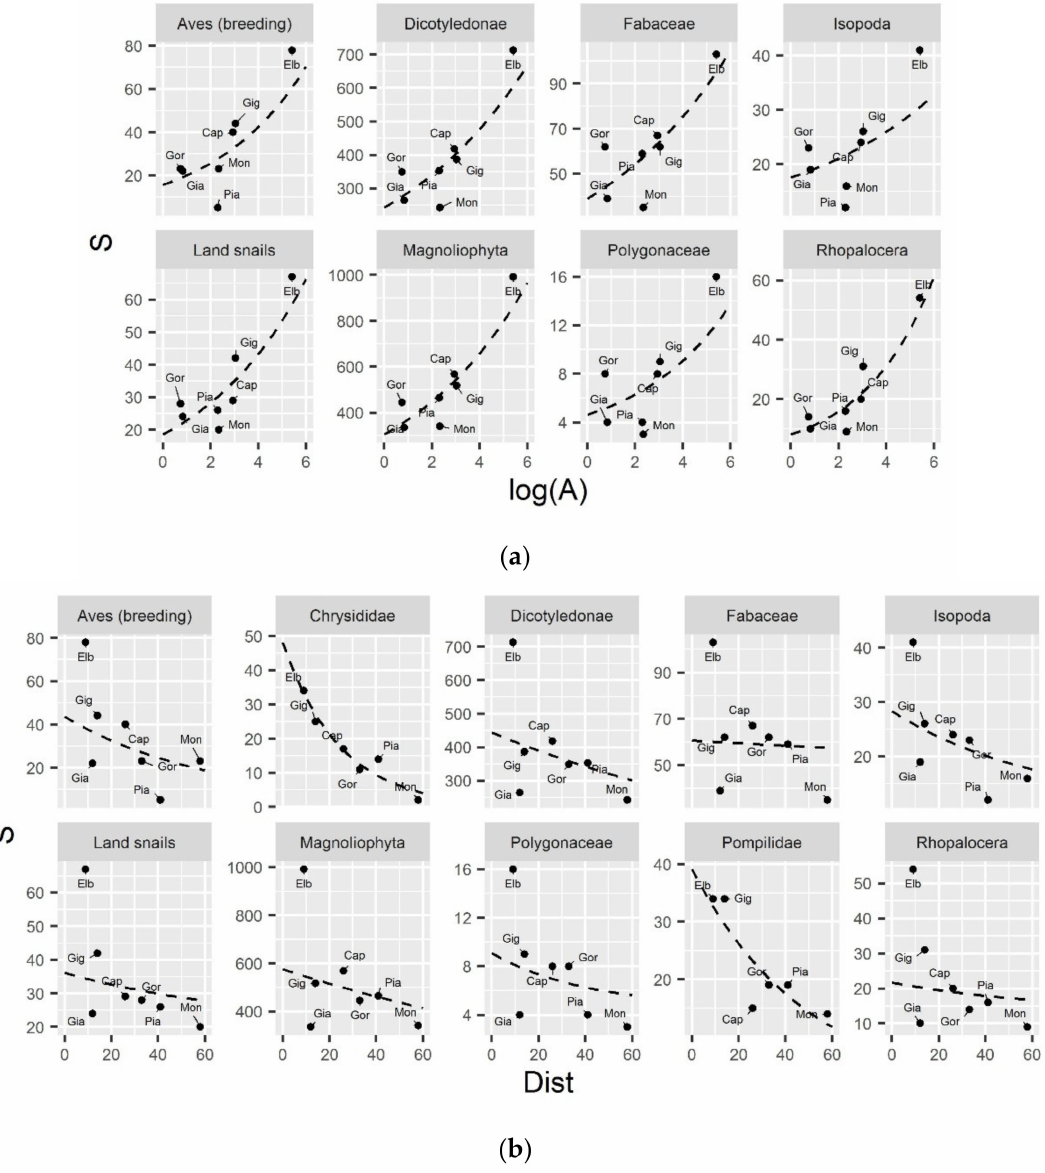
Figure 3. Equilibrium Hypothesis (EQH) according to the Logarithmic function: joined effect of logarithm of island area (log(A)) ( a ) and distance (D) ( b ) on species richness (S) of animal and plant taxa in the Tuscan